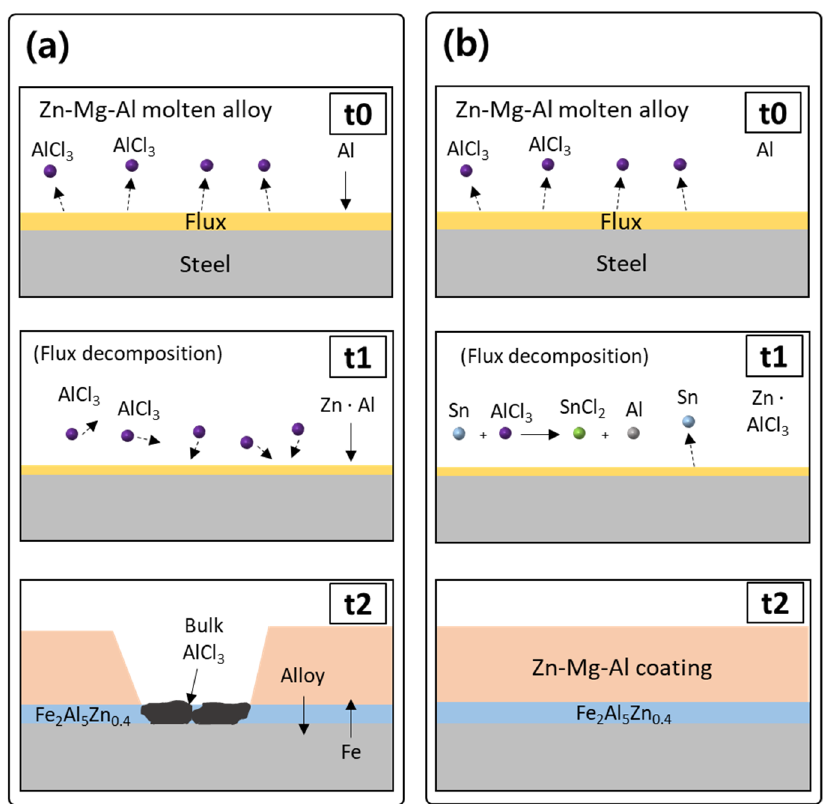
Figure 7. Schematic of the hot-dipped Zn–1Mg–1Al alloy coating formation: ( a ) NF and ( b ) SF30 samples; t0—time at which the fluxed steel is dipped into the bath, t1—time at decomposition of flux, and t2—after coating solidification.